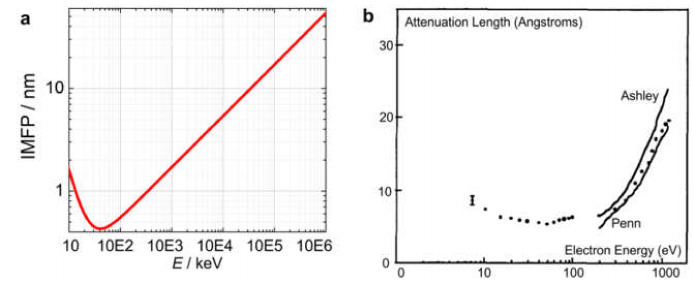
Figure 3. Inelastic mean free path (IMFP) as a function of electron energy. ( a ) IMFP calculated according to Equation (21). ( b ) IMFP measured based on the transmission of an electron beam through a thin amorphous carbon film as a function of the kinetic energy of the electron beam, using a transmission energy loss spectrometer [5]. Continuous lines are theoretical predictions for the IMFP by Ashley [6] and Penn [7], respectively; reprinted from [5], with permission from